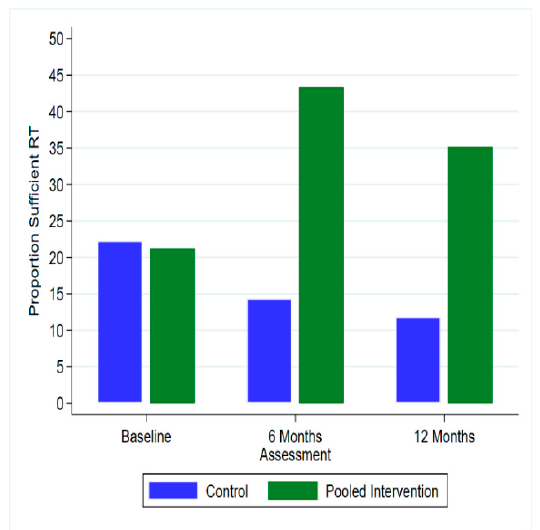
Figure 3. Proportion of Control Group and Pooled participants reporting sufficient resistance training (RT) at Baseline, 6 months and 12 months.